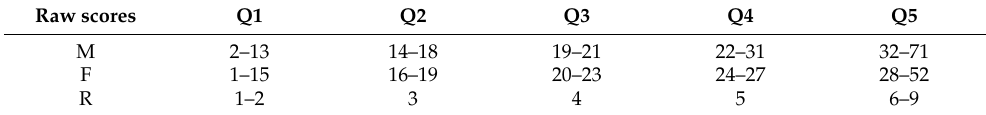
Table 2. Threshold of the quintiles of the total R, F, and M scores. The total M, F, and R scores were obtained by summing the partial values from the single PGFF categories.